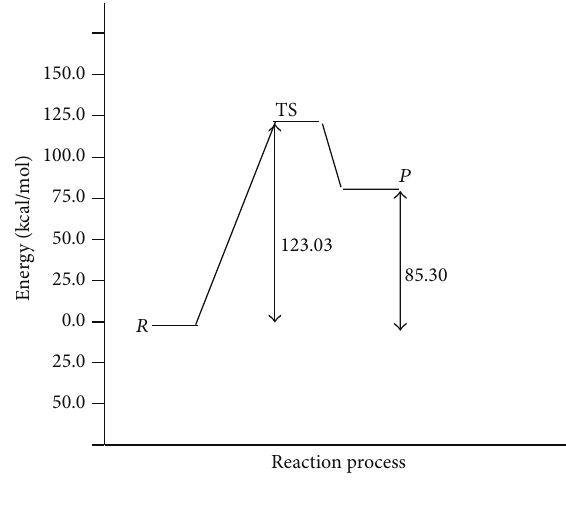
Figure 10: Potential energy diagram for hydrogenation of styrene oxide over Ni